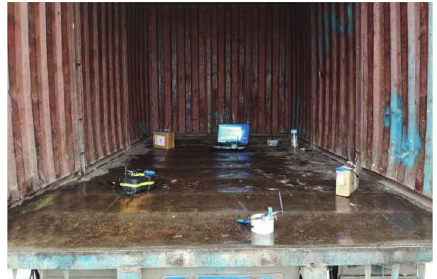
Figure 9: Zigbee nodes arranged in the carriageriage.